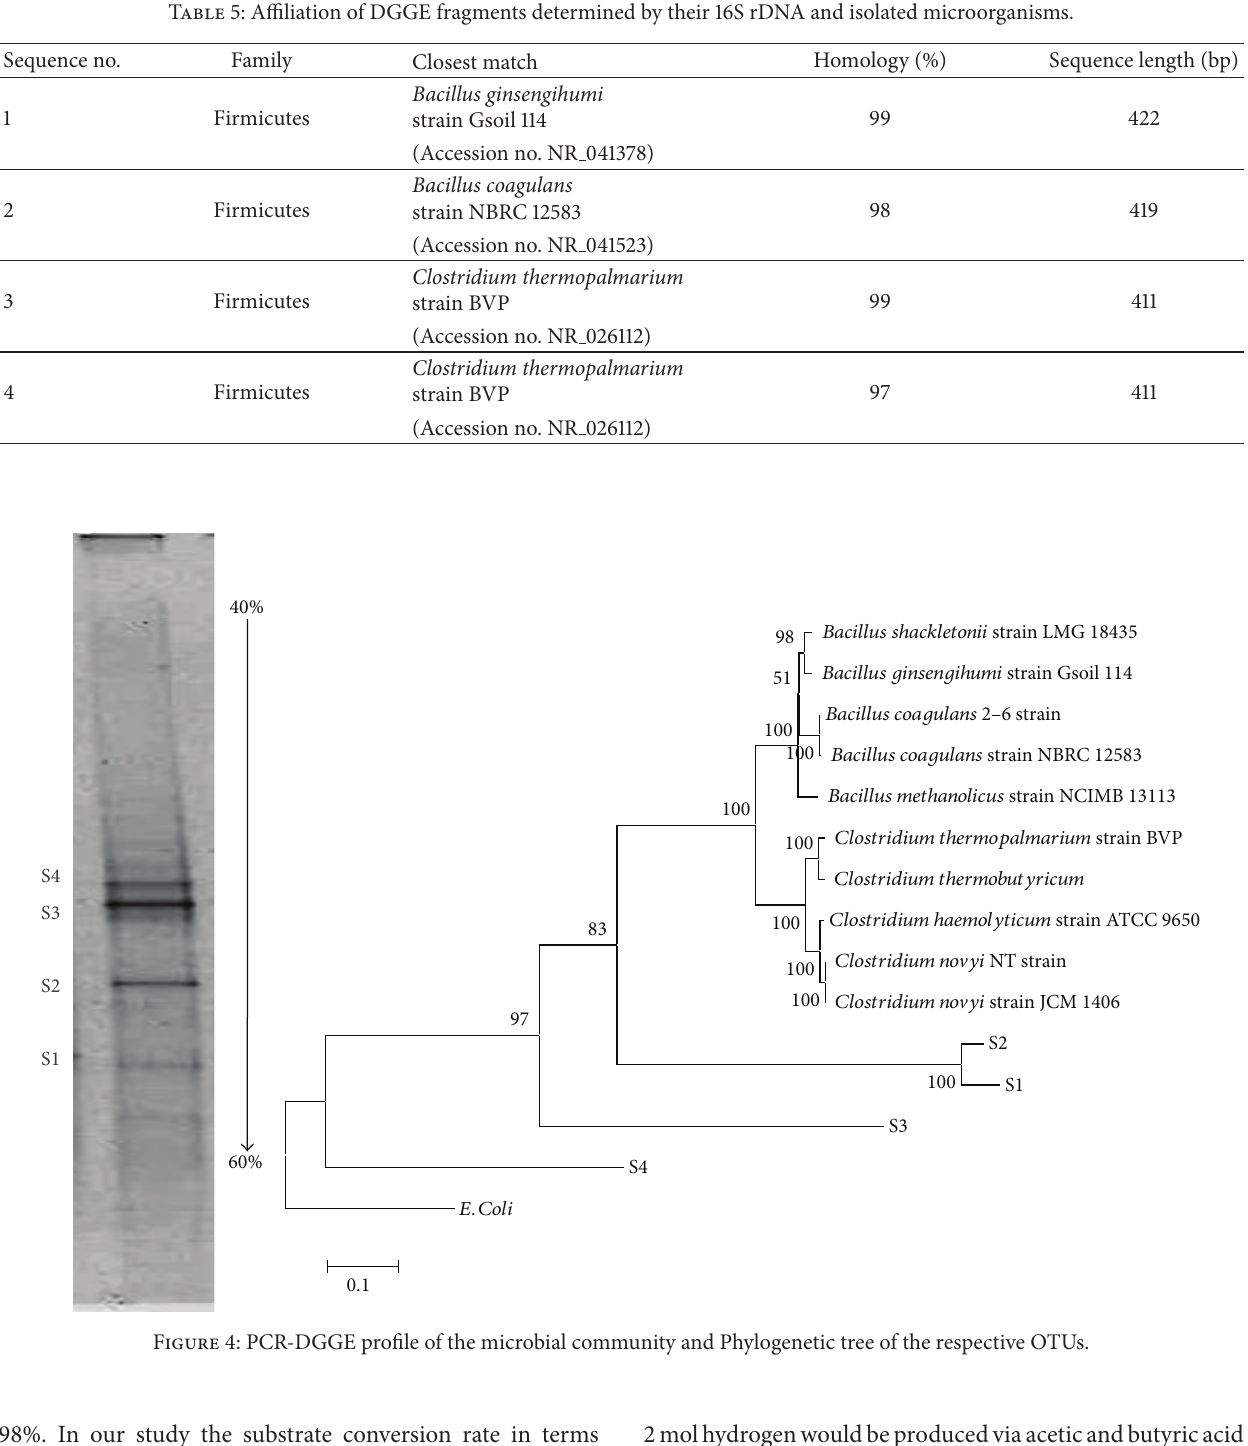
98%. In our study the substrate conversion rate in terms of total carbohydrate is only about 50% as indicated in our previous report